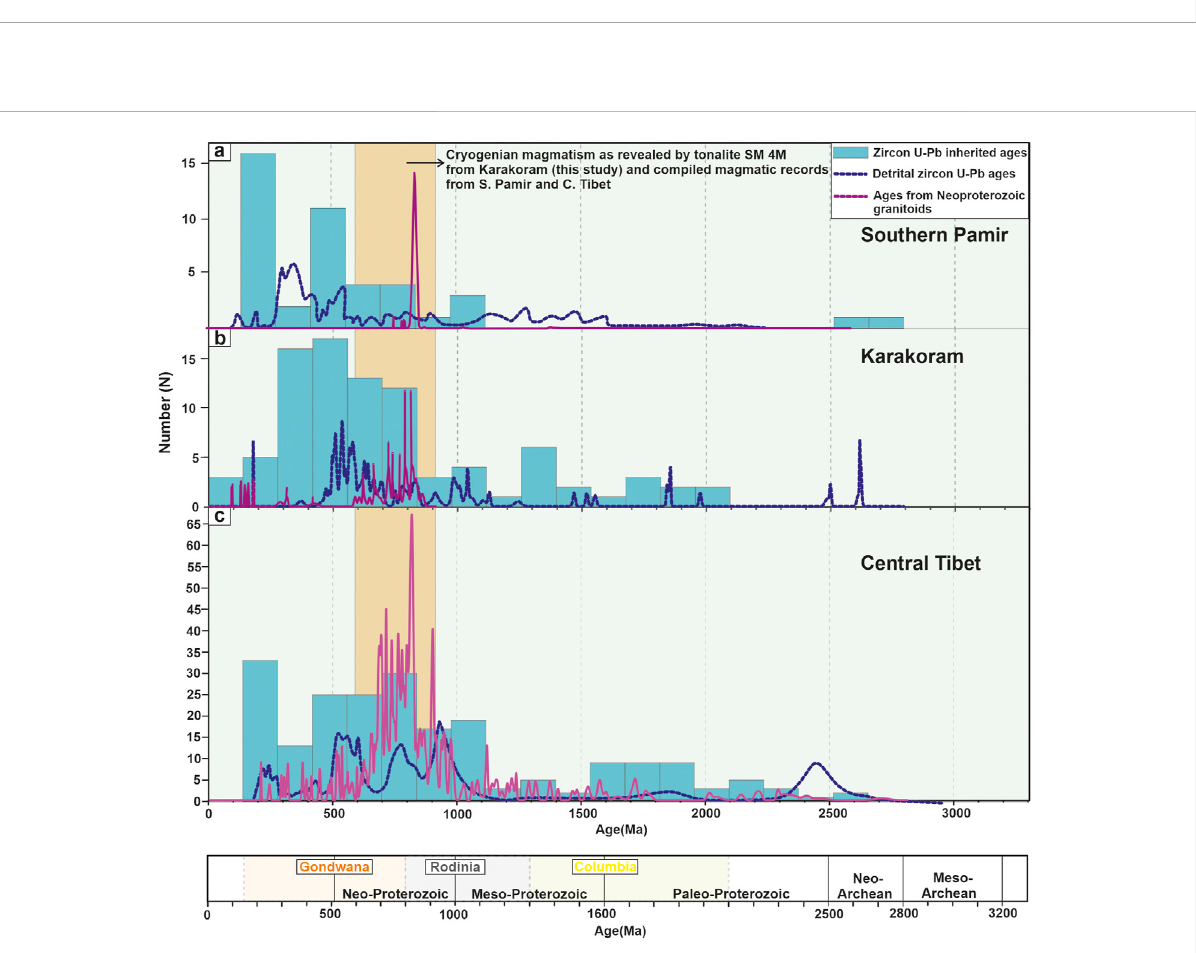
FIGURE 8 Probability density plotfor theinheritedzircon agesfrom theTriassic to Miocene granitoid,U – Pbdetrital ages, andNeoproterozoicU – Pbages from (A) the Karakoram, (B) Southern Pamir, and (C) Central Tibet (Data source-Karakoram: Boutonnet et al., 2012; Fraser et al., 2001; Heuberger et al., 2007; Kumar et al., 2017; Parrish and Tirrul, 1989; Pundir et al., 2020a; Pundir et al., 2020b; Ravikant et al., 2009; Schwab et al., 2004; Searle et al., 1998; Sen et al., 2014; Van buer et al., 2015; Weinberg et al., 2000; Southern Pamir: Chapman et al., 2018; Liu et al., 2020; Schwab et al., 2004;CentralTibet: Hao etal.,2016; Ouetal., 2017;Schwab etal., 2004;Suiet al.,2013;Wang etal., 2020;Wu et al.,2016;Zhai etal., 2013). Density plots of U – Pb detrital ages are taken from previous studies. Tibet: Gehrels et al., 2011; He et al., 2019; Song et al., 2017; Pamir: Chapman et al., 2018; Karakoram: Bornemanetal., 2015. DensityplotsofNeoproterozoic U – Pbages. Data Source: Tibet: Huet al.,2005;Dong et al.,2011;Liuet al.,2021; Yu et al., 2021 (n=290), Karakoram: This study (n=45), Pamir: Zhang et al., 2018 ( n =199).